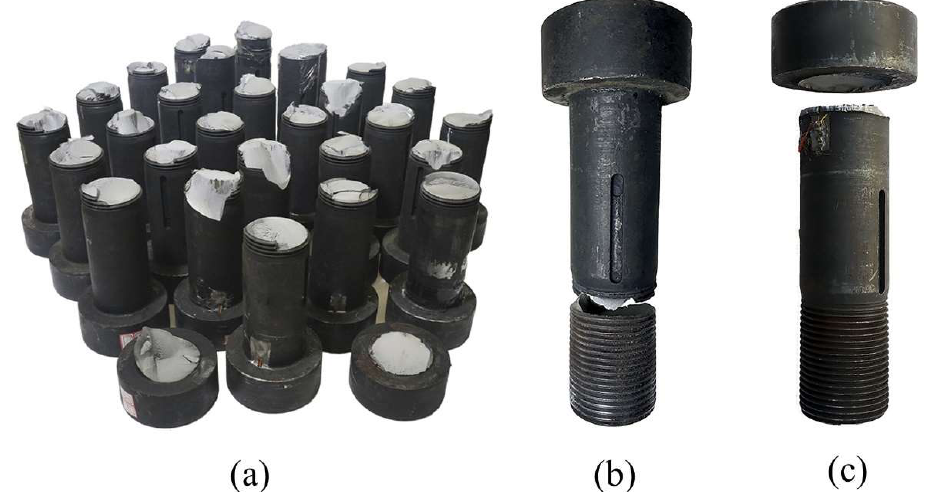
Figure 9. The M60 high-strength bolt’s failure modes under fatigue loading. ( a ) the fatigue fracture of all specimens; ( b ) The first fatigue failure form of specimens ( c ) The second fatigue failure form of specimens